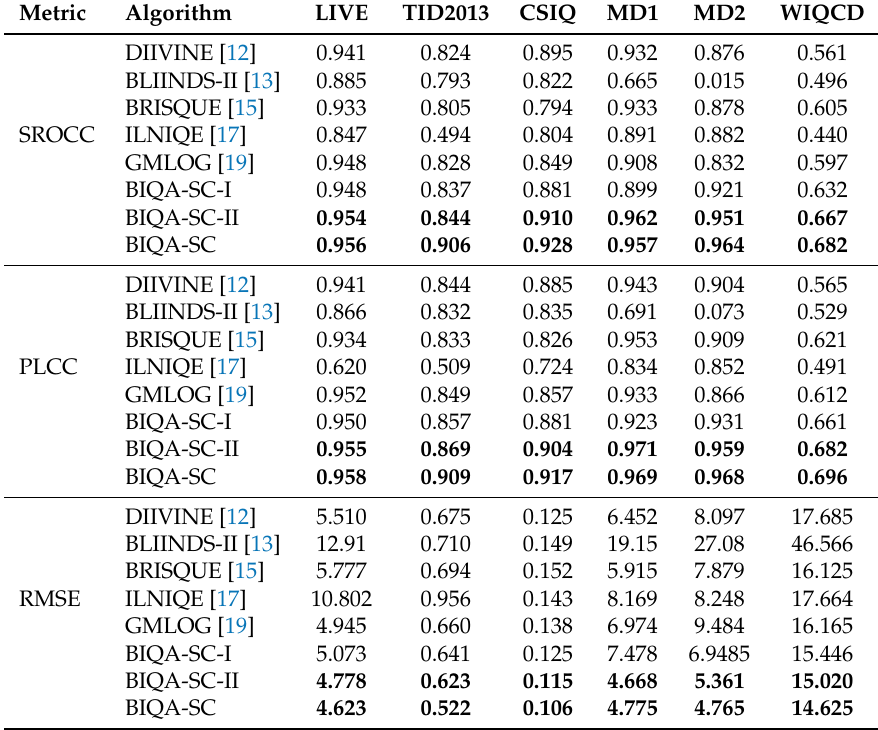
Table 2. The median of SROCC, PLCC, and RMSE across the 1000 train-test trials on individual databases. The best two performances in terms of SROCC, PLCC, and RMSE are highlighted in boldface.